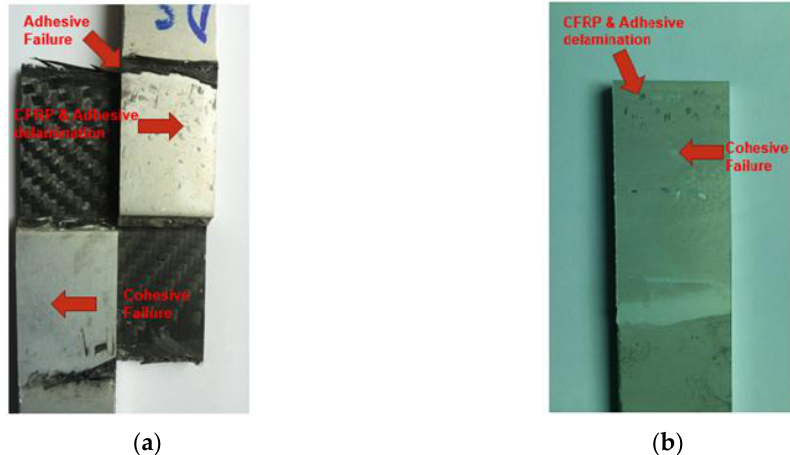
Figure 5. Fracture surfaces of double strap lap joints ( a ) match ( b ) mismatch